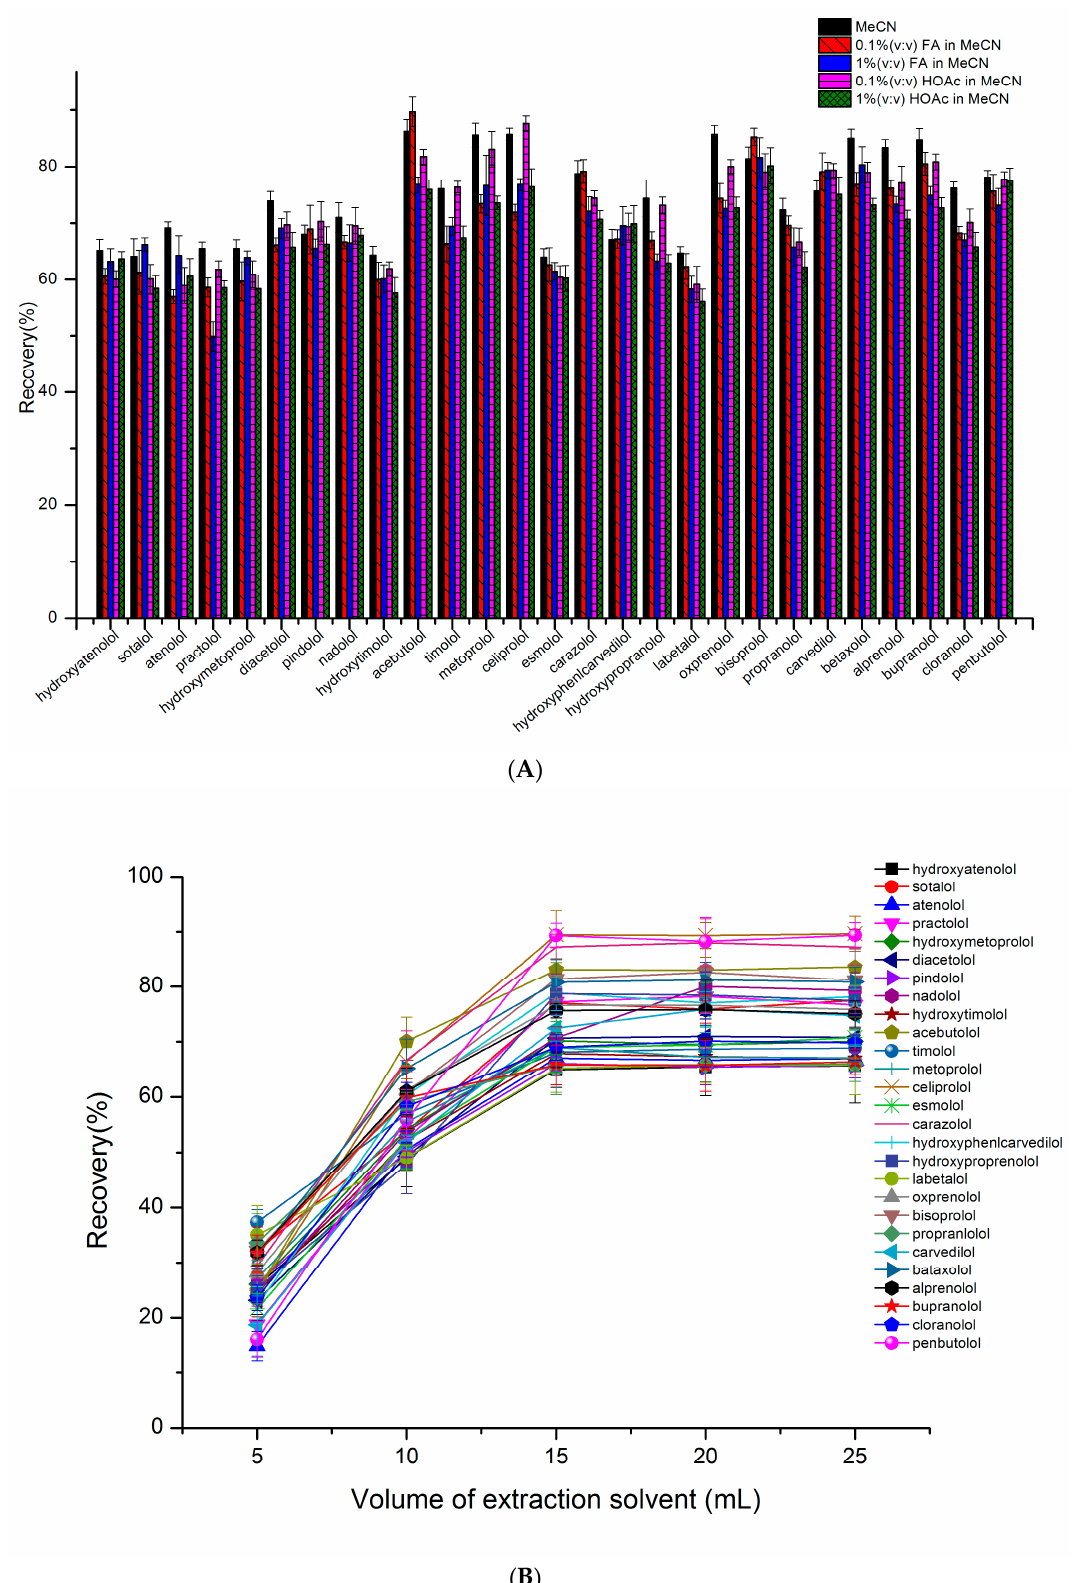
Figure 7. The effect of extracting solvents on the recovery of 27 analytes in milk powder. ( A ) The type of extract solvent, ( B ) the volume of extraction solvent (n = 3). Taking into account the characteristics of the β -blockers and matrix interferences in milk powder samples, low temperature high-speed centrifugation, low temperature high-speed centrifugation +